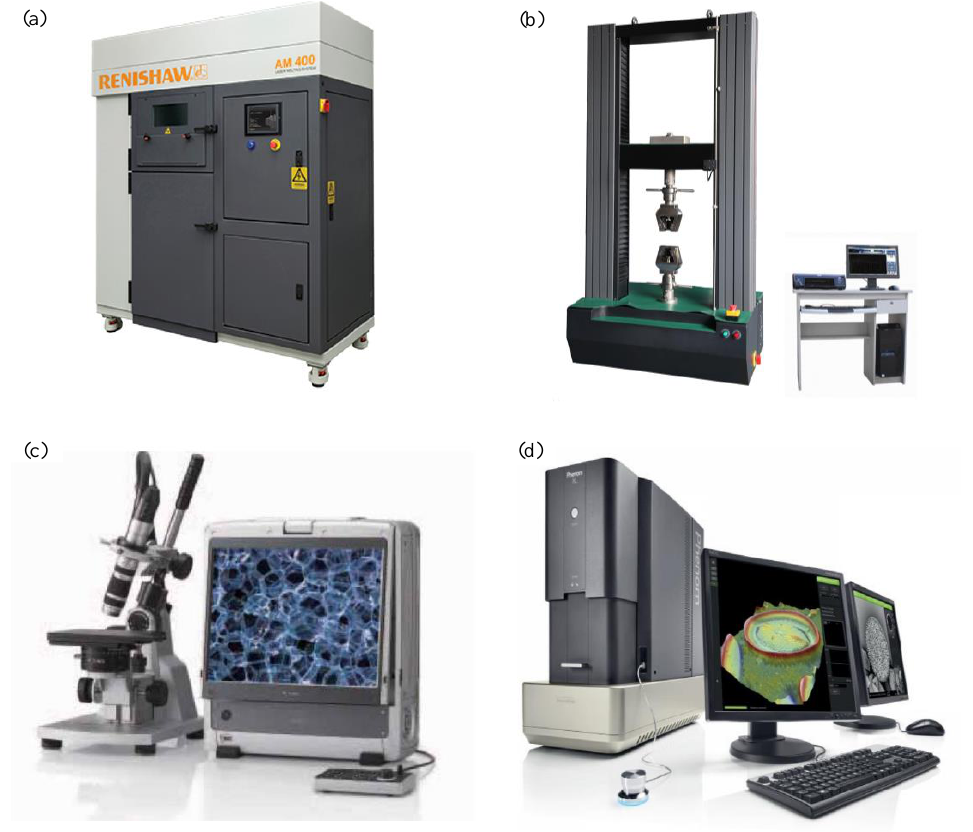
Figure 2. Experimental equipment. ( a ) Metal 3D printer; ( b ) Mechanical drawing machine; ( c ) Super deep scene 3D microscope; ( d ) Scanning electron microscope.